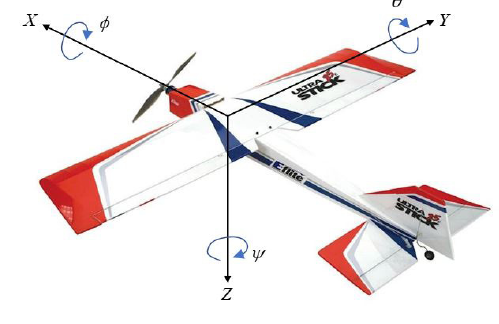
Figure 1. The coordinate system of a